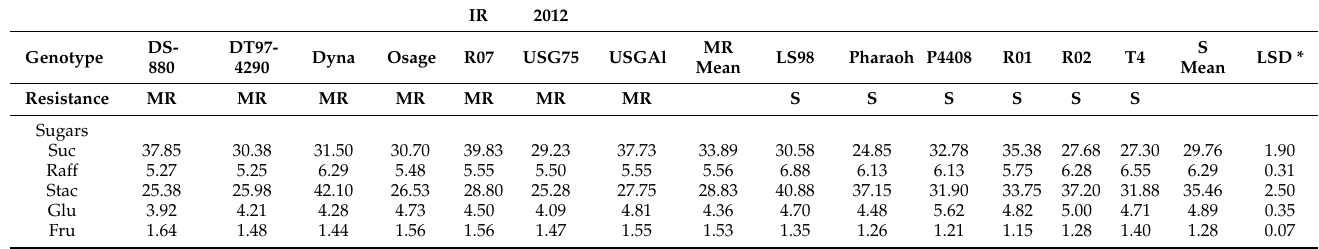
Table 4. Levels (mg/g) of seed sucrose (Suc), raffinose (Raff), stachyose (Stac), glucose (Glu), and fructose (Fru) in moderately resistant (MR) and susceptible (S) soybean genotypes to charcoal rot infection under irrigated (IR) and non-irrigated (NIR) conditions. The experiment was conducted in 2012 in Jackson, TN,